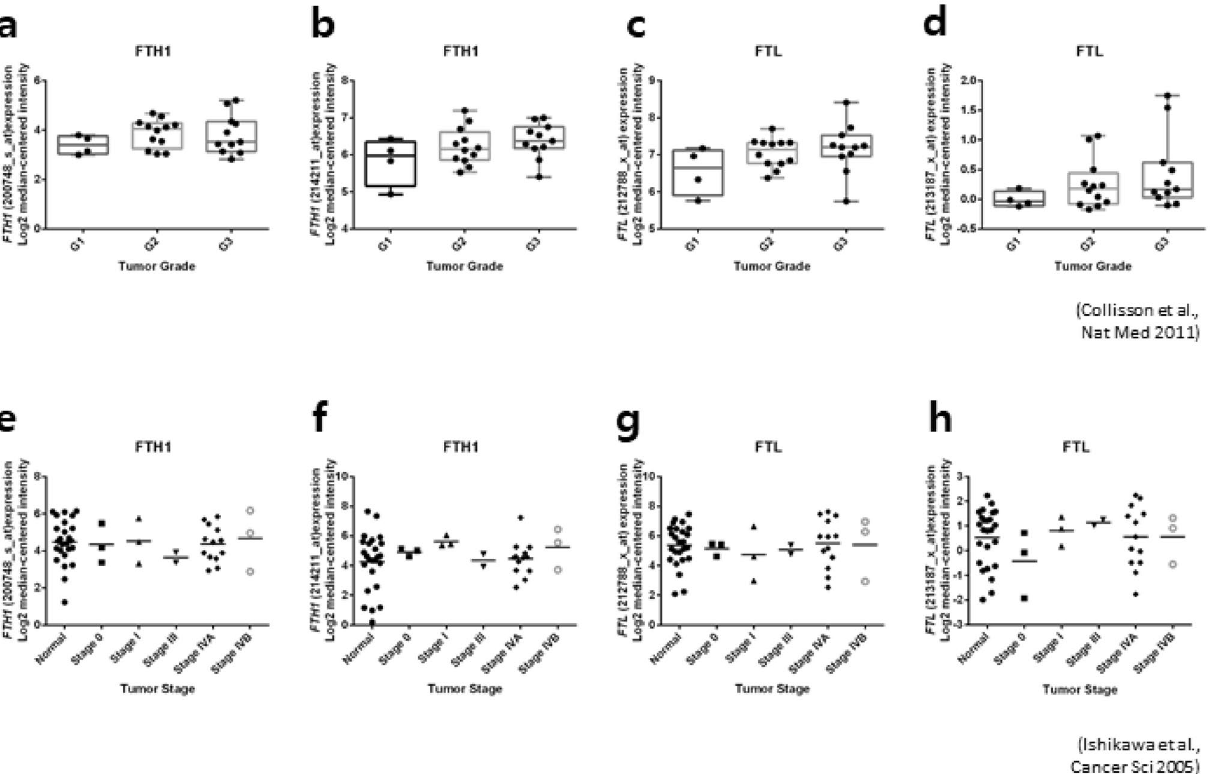
Figure 3. Oncomine analysis of Ferritin high chain ( FTH1 ) and ferritin light chain ( FTL ) mRNA expressions in normal and/or human pancreatic cancer tissues. ( a – d ) FTH1 and FTL mRNA expression profiles in different cancer grades: G1 (n = 4), G2 (n = 12), G3 (n = 11) and ( e – h ) stages: normal subjects (n = 25), stage 0 (n = 3), stage I (n = 3), stage III (n = 2), stage IVA (n = 13), and stage IVB (n = 3) pancreatic cancer